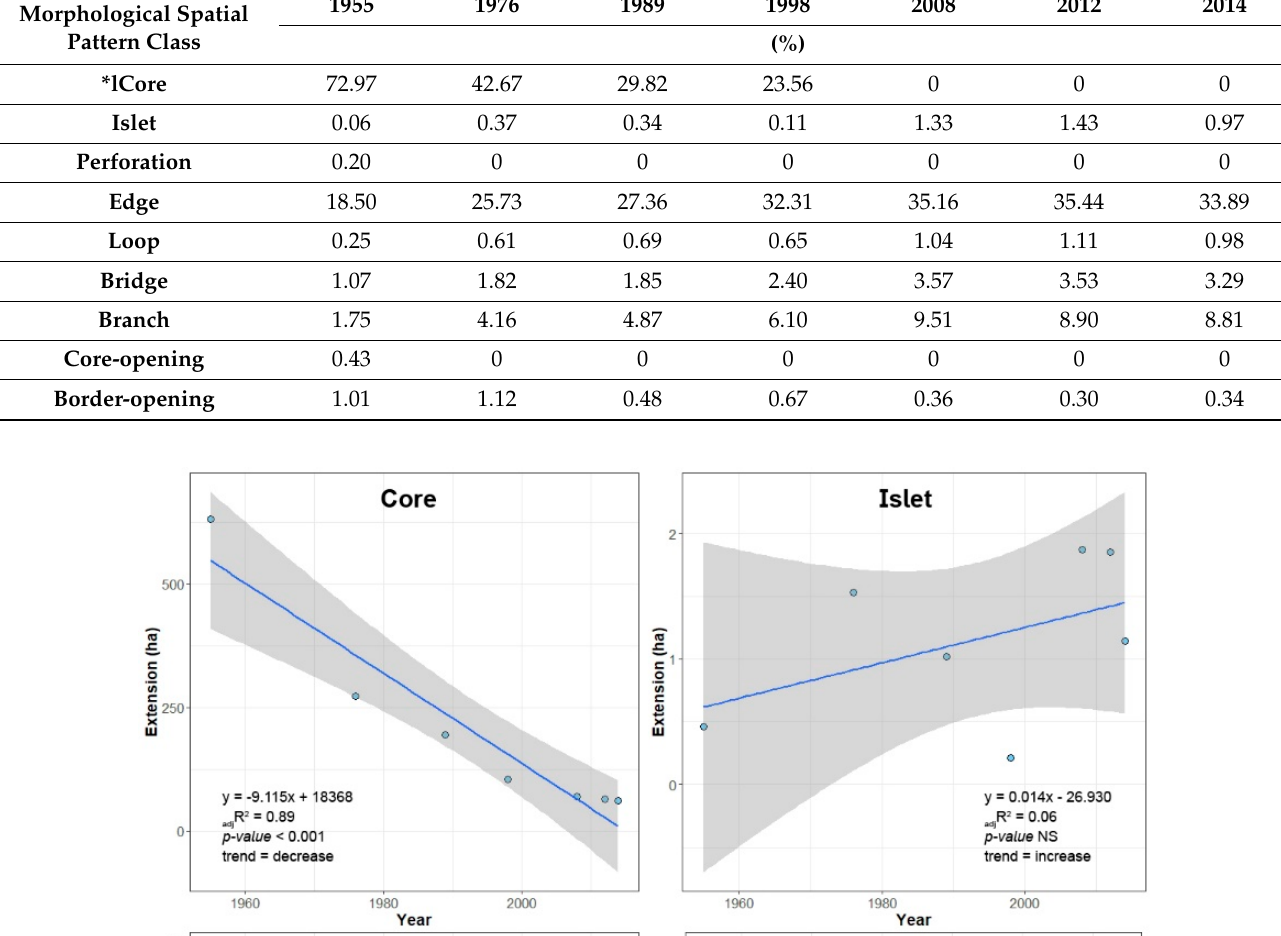
Figure 7. The agricultural terraced patch dynamics of the study area from 1955 to 2014.